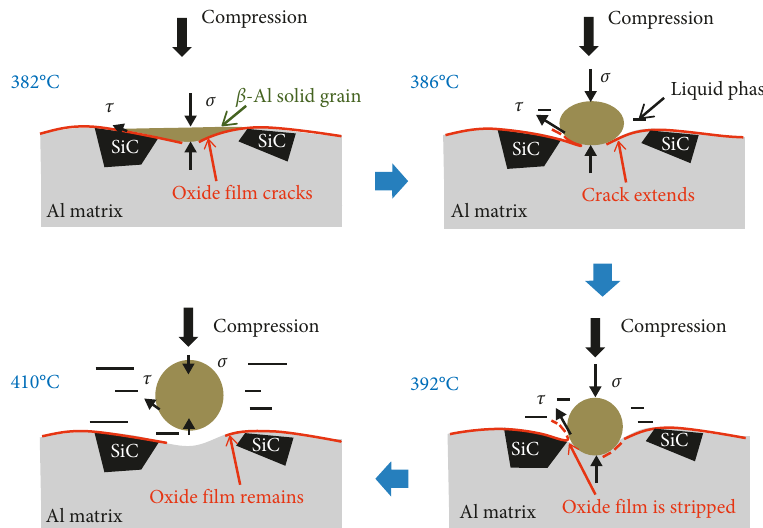
Figure 9: Model of the disruption of the surface oxide film during brazing.